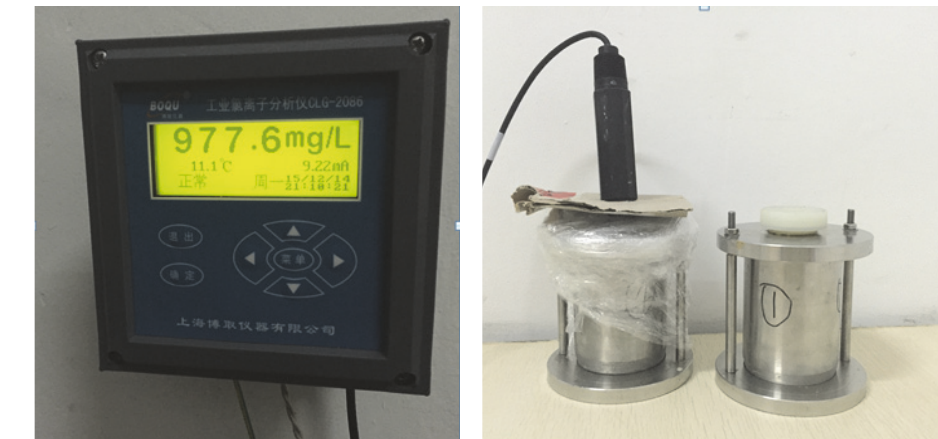
Figure 6: Radial diffusion system and Cl − online monitor.